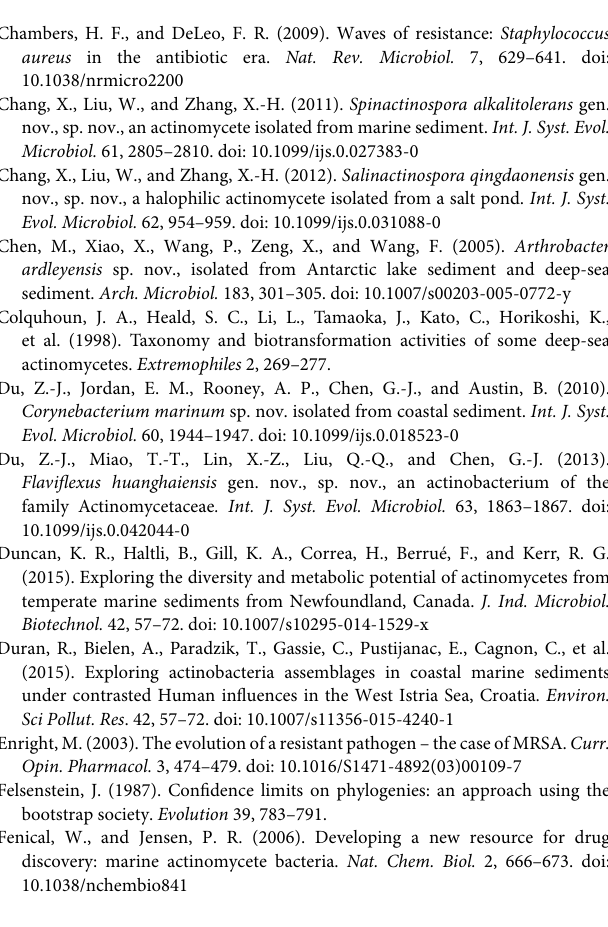
Figure S1 | Distribution of actinobacterial isolates in sediment samples from site 1 (Punta Ángeles Lighthouse) and site 2 (Torpederas Beach) of Valparaíso bay. Site 1 comprises samples V1, V2, and V3, whereas site 2 comprises samples V4, V5, and